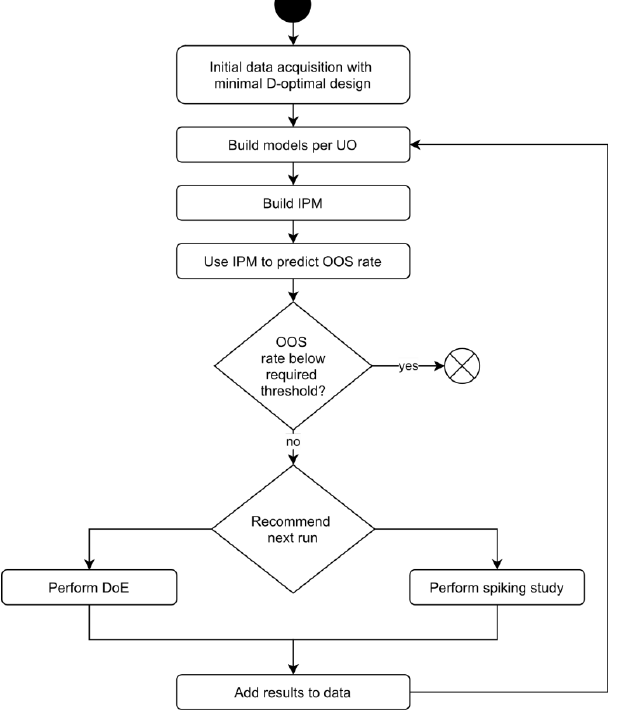
Figure 5. The hDoE recommender system that minimizes OOS by iteratively augmenting data and predicting optimal experiments.